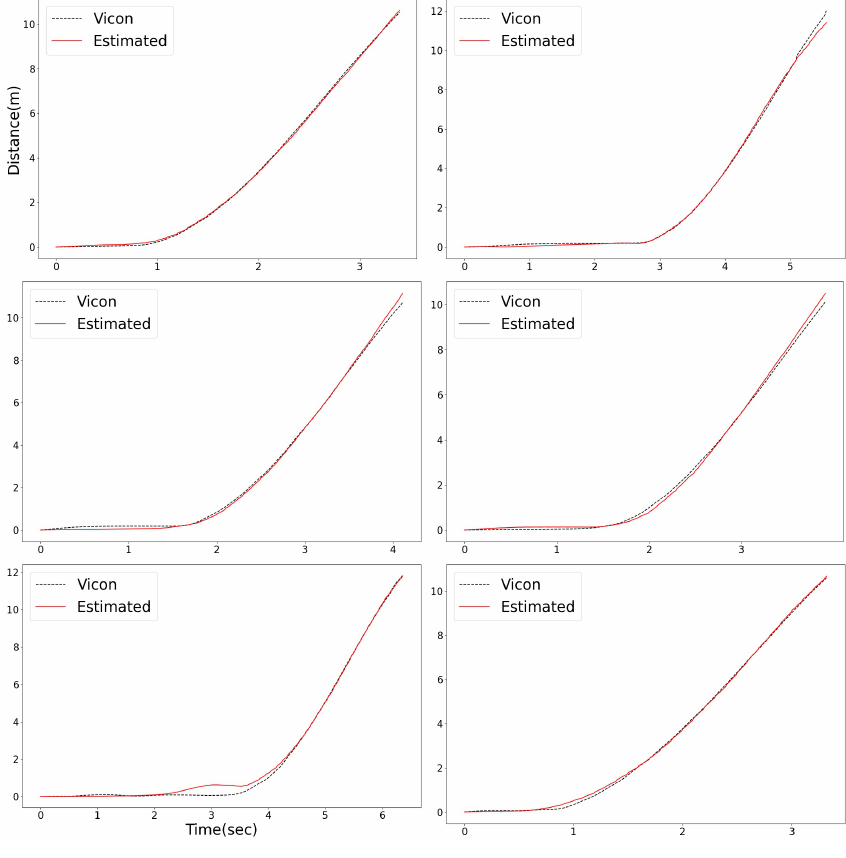
Figure 24. The 2D moving distance of the athlete: comparison with Vicon data.